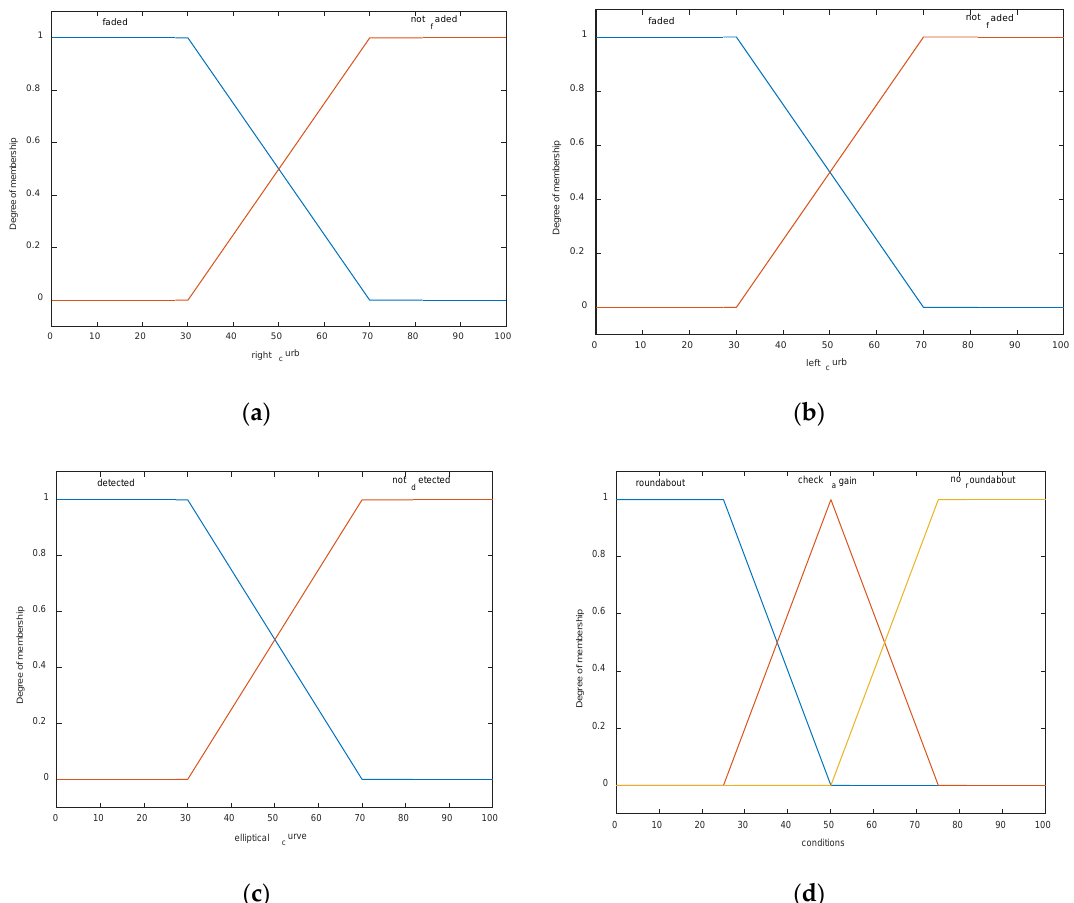
Figure 3. Input / output fuzzy membership functions: ( a ) input: right curb, ( b ) input: left curb, ( c ) input: elliptical curve, and ( d ) output: conditions.